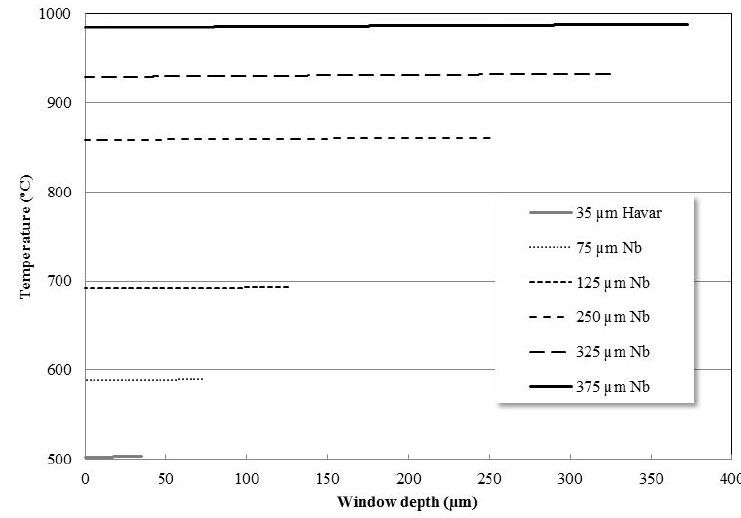
Figure 23. Temperature of the distinct niobium target windows along their depth axis.